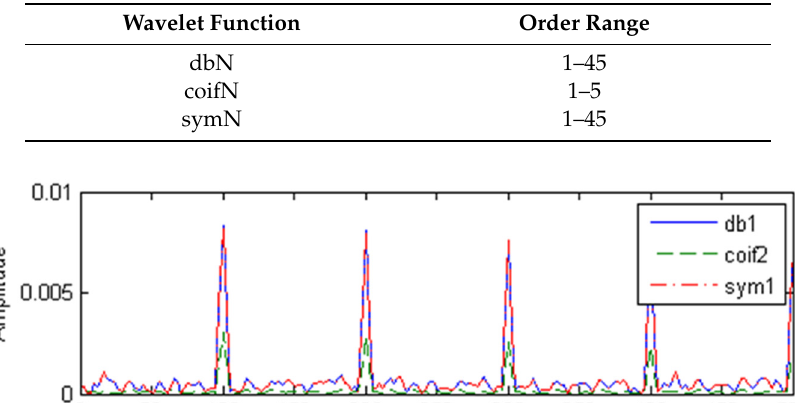
Table 1. Wavelet packet parameters.